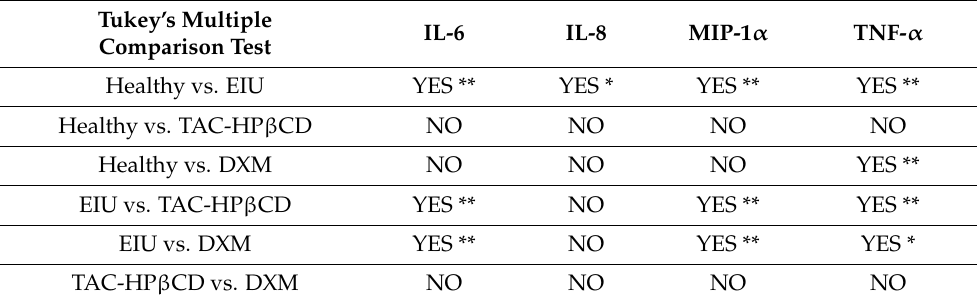
Figure 2. Anti-inflammatory in vivo effect ( a ) IL-6 ( b ) IL-8 ( c ) MIP-1 α and ( d ) TNF- α mRNA expres- Figure 2. Anti ‐ inflammatory in vivo effect ( a ) IL ‐ 6 ( b ) IL ‐ 8 ( c ) MIP ‐ 1 α and ( d ) TNF ‐α mRNA expression in healthy eyes sion in healthy eyes (Healthy), EIU untreated rats (EIU), EIU rats treated with dexamethasone (DXM) (Healthy), EIU untreated rats (EIU), EIU rats treated with dexamethasone (DXM) and EIU rats treated with TAC ‐ HP β CD and EIU rats treated with TAC-HP β CD (TAC-HP β CD). ( n = 10 eyes per group). Bars represent (TAC ‐ HP β CD). ( n = 10 eyes per group). Bars represent mean ± SD (* p < 0.05; ** p < 0.005). mean ± SD (* p < 0.05; ** p < 0.005). Table 2. Existence (YES) or absence (NO) of statistical significance calculated through a Tukey’s multiple comparison test among Healthy, EIU, DXM and TAC-HP β CD groups (* p < 0.05; ** p <